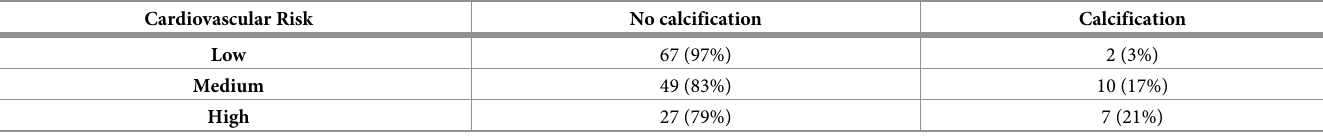
Table 2. Coronary calcification in a bi-categorical distribution by cardiovascular risk.